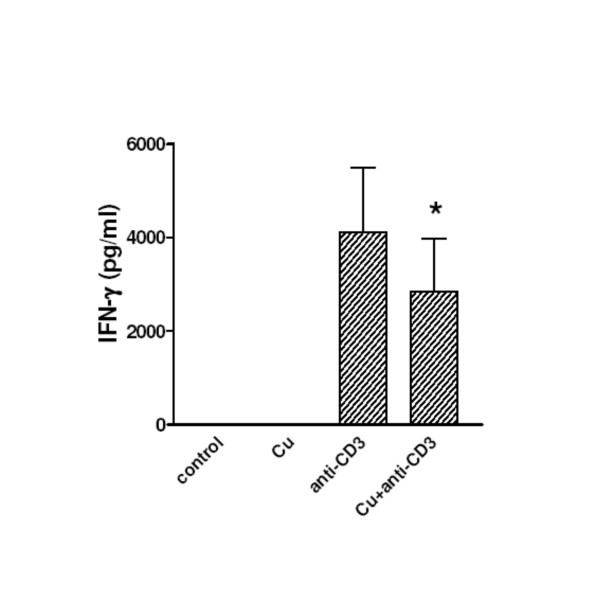
In vitro effects of exogenous Cu upon IFN-γ production in healthy controls. Mononuclear cells from normal donors were incubated for 48 h in the absence or presence of anti-CD3 (200 ng/ml), Cu (10 μM CuCl2) or both. Bars represent mean (+/-SEM) IFN-γ concentration in supernatants from six different donors. Unstimulated cells or cells stimulated with Cu alone did not produce IFN-γ. *p < 0.05 vs. anti-CD3-stimulated cells (Wilcoxon signed rank test).